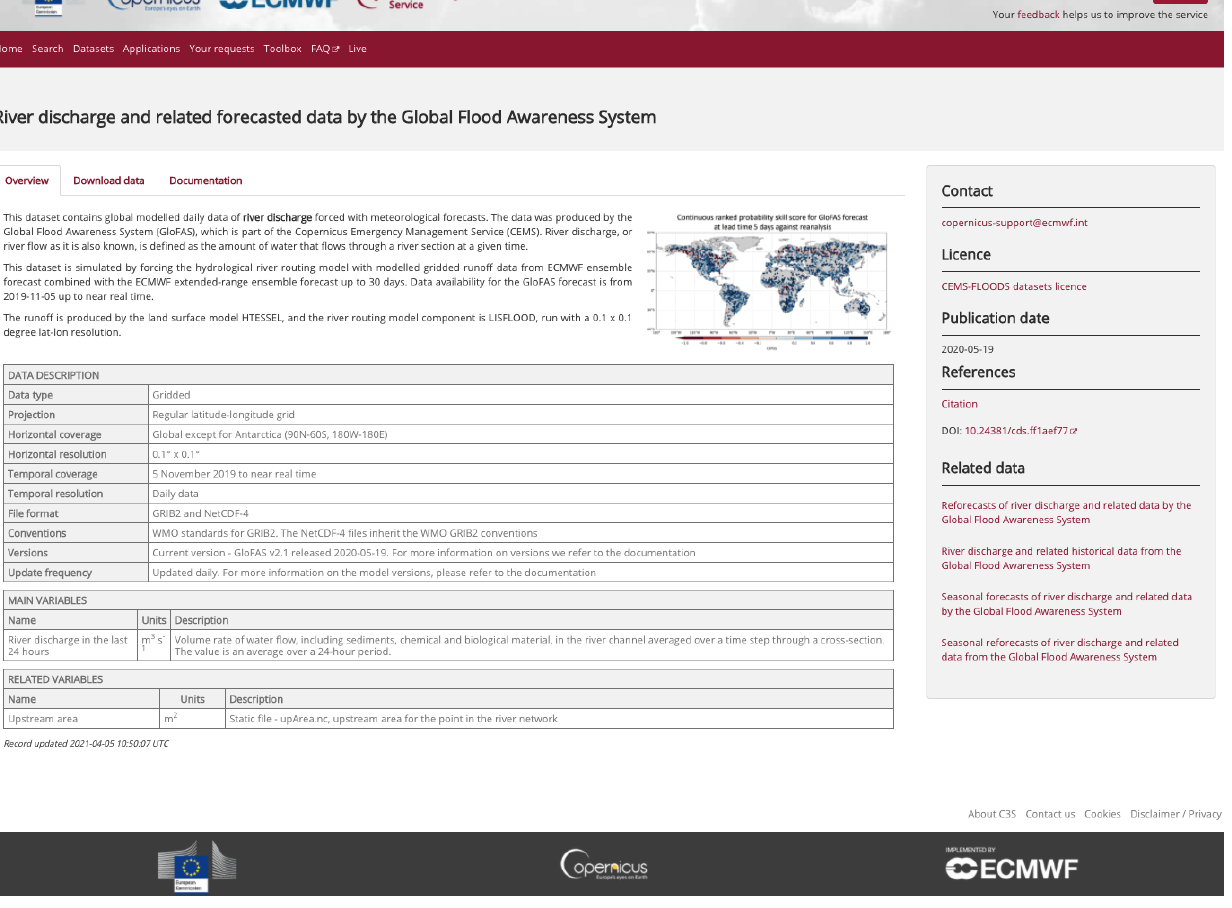
Figure 10. The GloFAS river discharge forecast landing page on the C3SClimate Data Store (CDS: https://cds.climate.copernicus.eu/cdsapp# !/dataset/cems-glofas-forecast?tab=overview, last access: 3 December